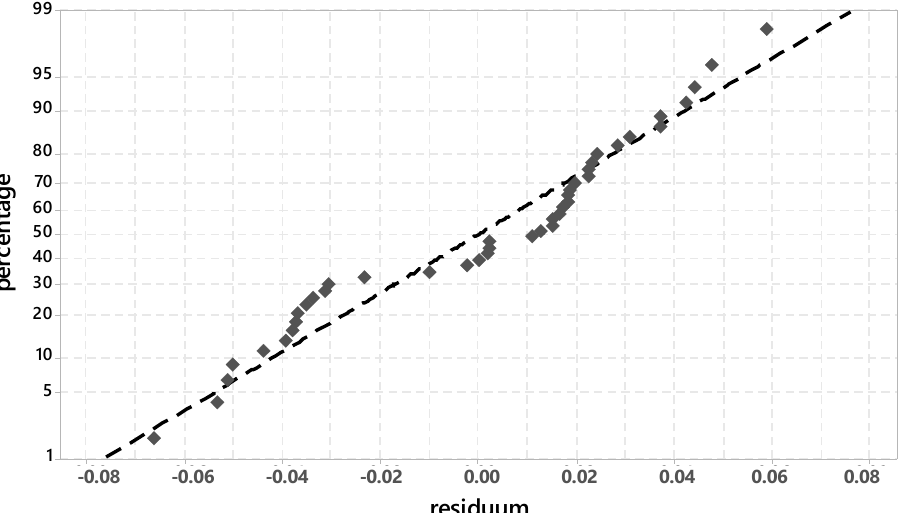
Figure 2. Probability plot for normal distribution for the degree of hydration phase (XRD ‐ peak 32 ‐ 32.5 °2 ϑ ).